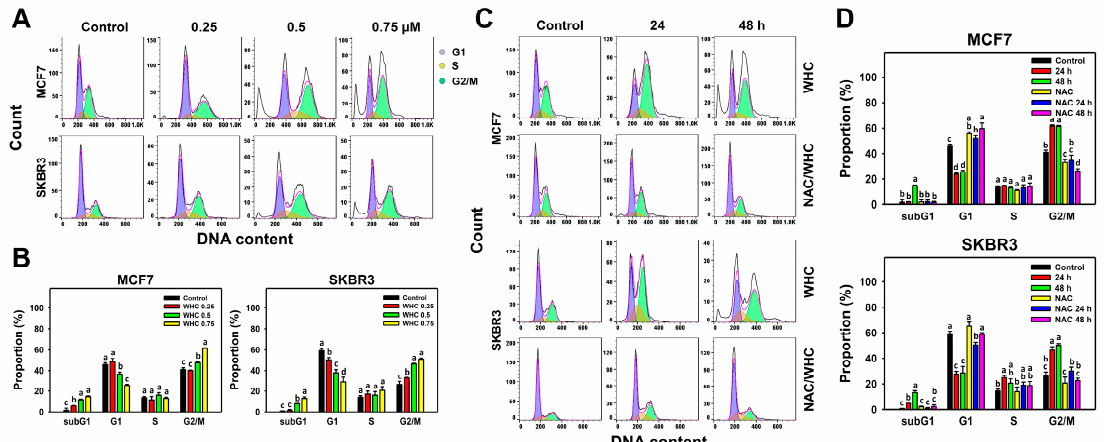
Figure 2. WHC disturbed cell cycle progression of breast cancer cells. ( A , B ) Cell cycle profiles and statistics for dose e ff ects of WHC. Breast cancer (MCF7 and SKBR3) cells were treated with